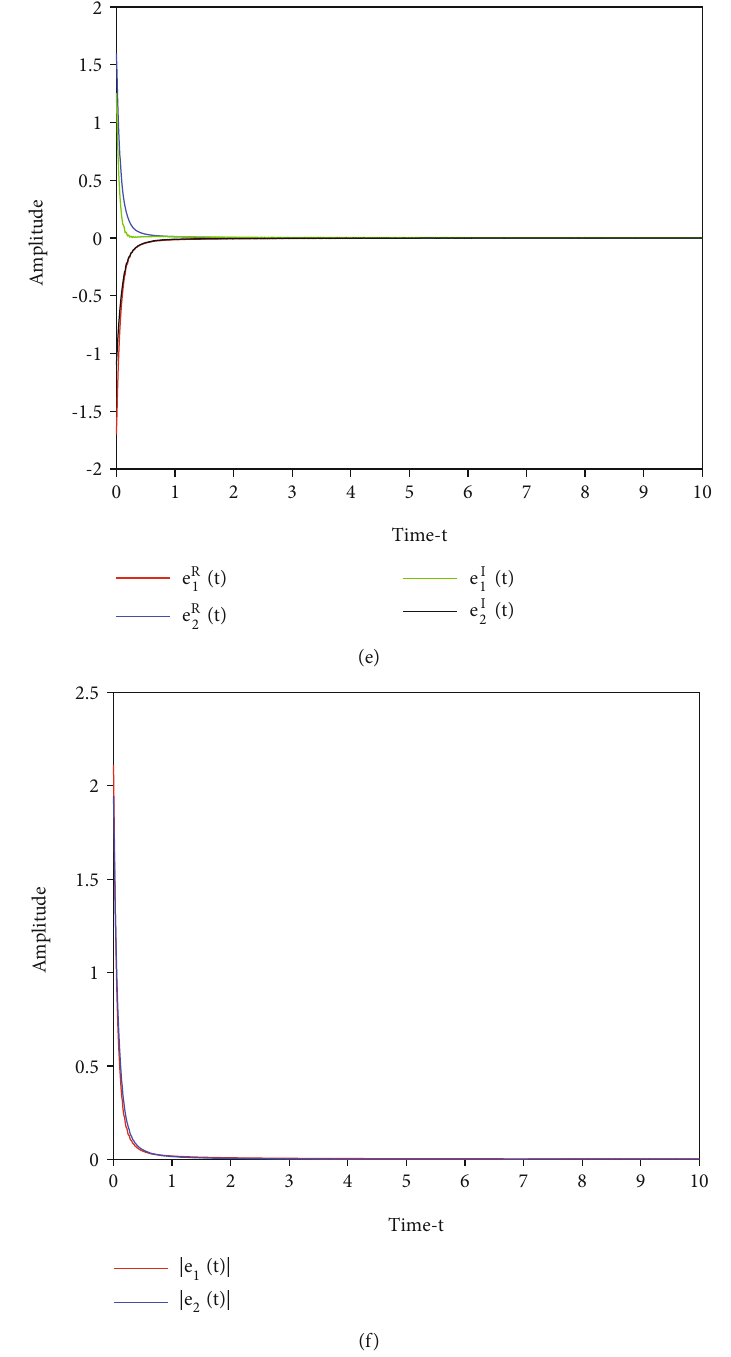
Figure 6: (a, b) The real parts of synchronization state trajectories with controller (42). (c, d) The imaginary parts of synchronization state trajectories with controller (42). (e) The error trajectories with controller (42). (f) The error modulus trajectories with controller